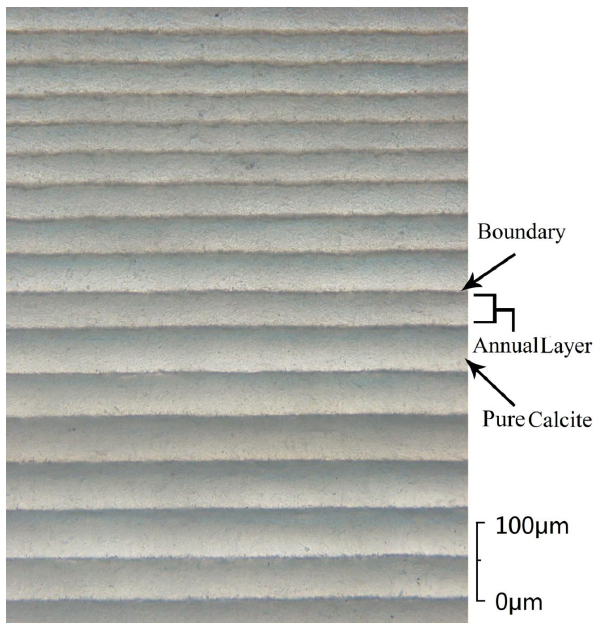
Fig. 2. Micrograph (using a 10 × objective lens) showing examples of typical well-formed annual bands preserved in a small columnar stalagmite NH33.